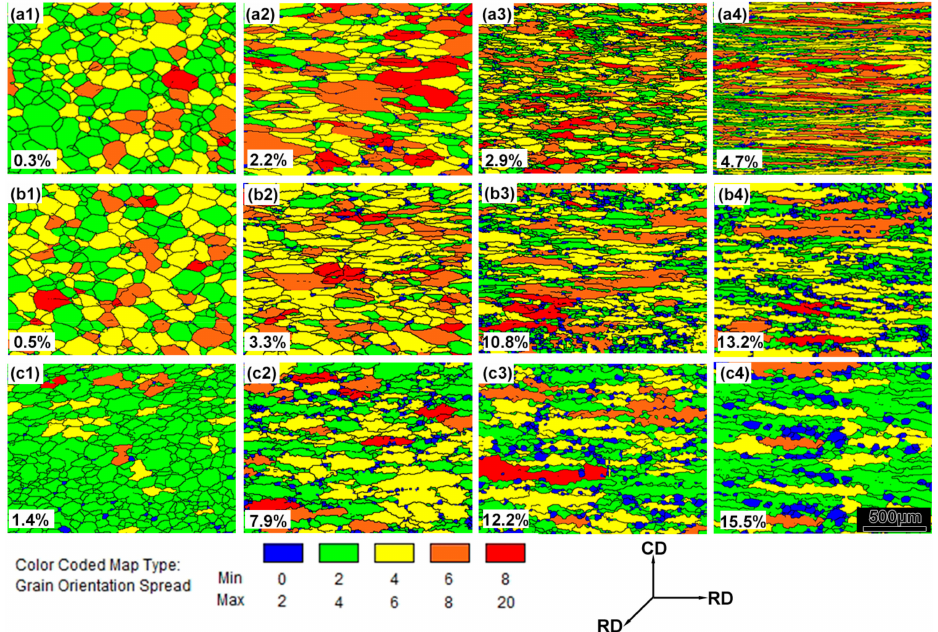
Figure 4. Grain orientation spread of the samples with different parameters: ( a 1)–( a 4) are under 1 s − 1 with 20%, 40%, 60%, and 80% reduction; ( b 1)–( b 4) are under 0.1 s − 1 with 20%, 40%, 60%, and 80% reduction; ( c 1)–( c 4) are under 0.01 s − 1 with 20%, 40%, 60%, and 80% reduction; the compressing temperature is 1153 K; the blue grains are selected as the recrystallization grains.